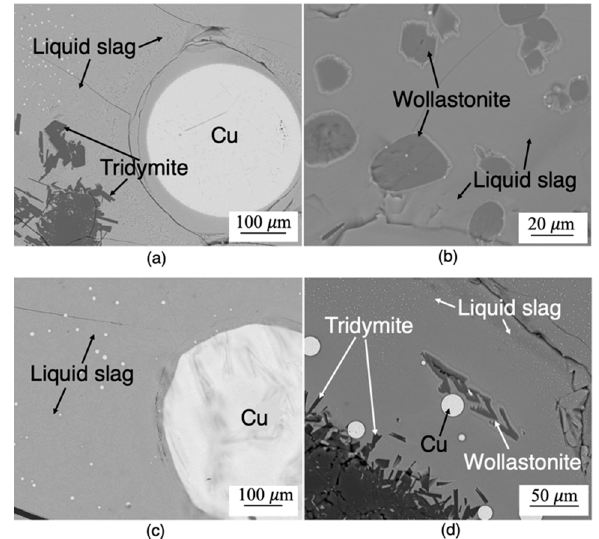
Figure 4. Scanning electron micrographs of quenched industrial liquid slags in equilibrium with solid phases, saturated with metallic copper and with addition of CaO. ( a ) Tridymite at 1150 °C; ( b ) wollastonite at 1150 °C; ( c ) tridymite at 1200 °C; ( d ) tridymite and wollastonite at 1200 °C.